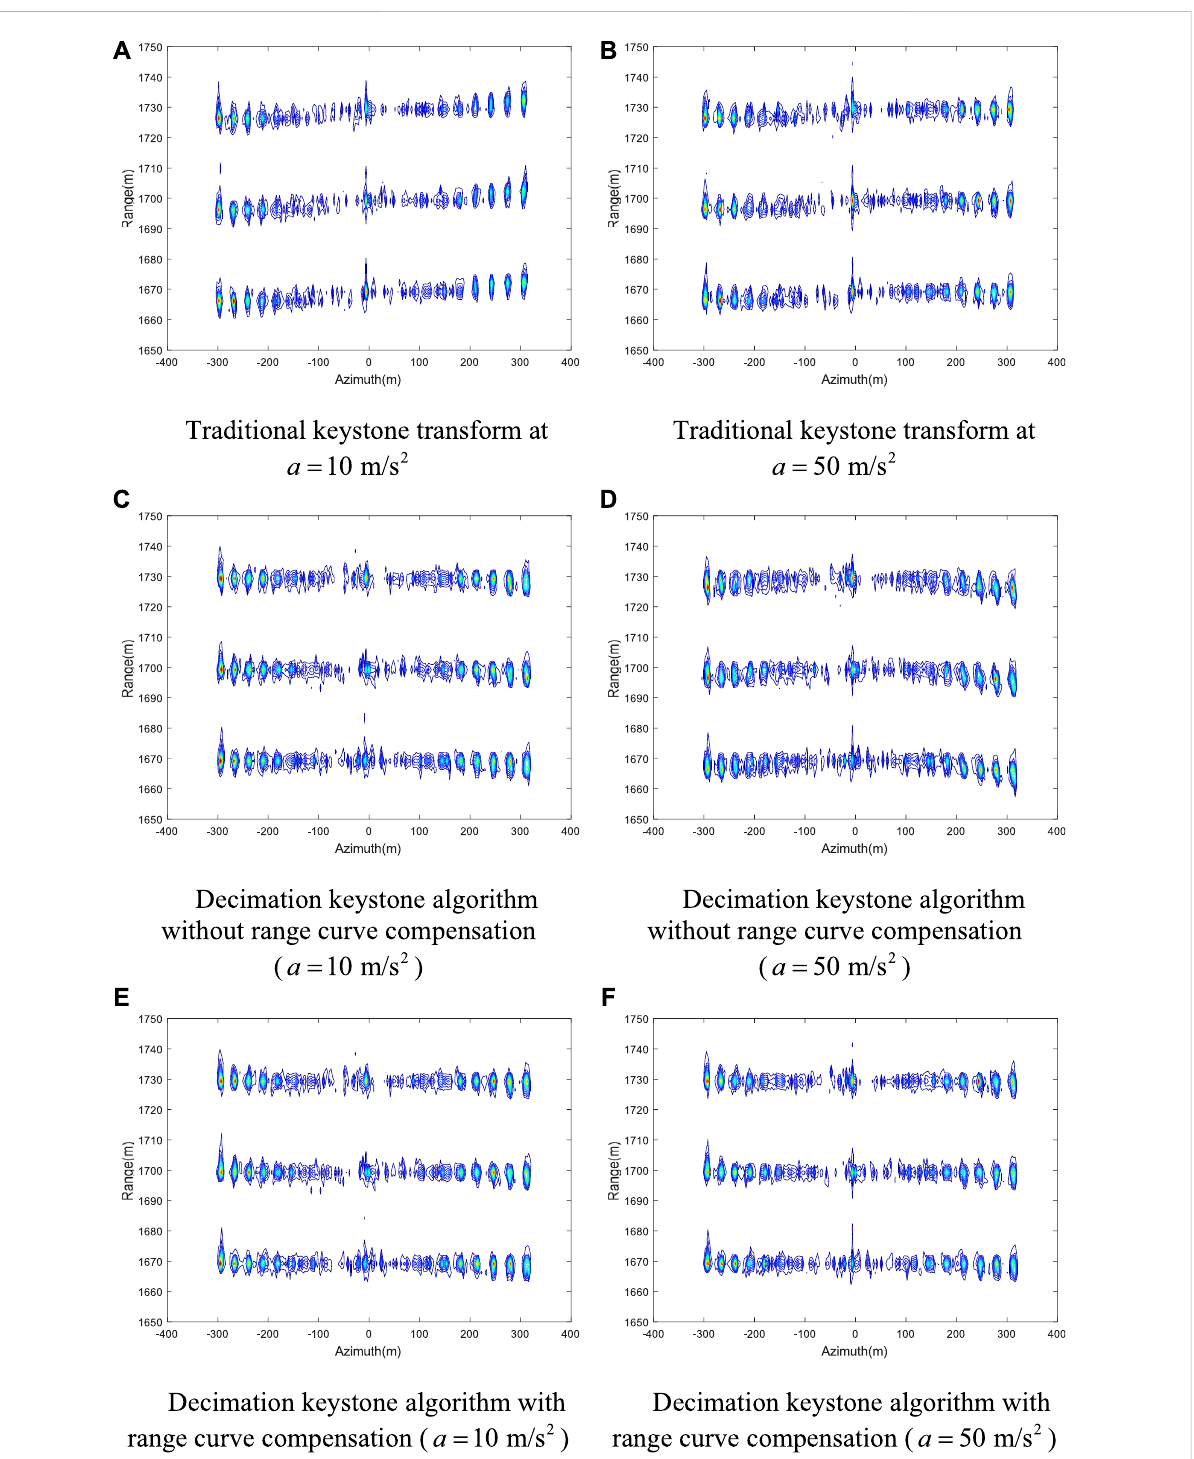
FIGURE 6 Comparison of image results of the uniform acceleration platform. (A) Traditional keystone transform at a (cid:2) 10 ( m / s ) 2 (B) Traditional keystone transform at a (cid:2) 50 ( m / s ) 2 . (C) Decimation keystone algorithm without range curve compensation ( a (cid:2) 10 ( m / s ) 2 ). (D) Decimation keystone algorithm without range curve compensation ( a (cid:2) 50 ( m / s ) 2 ). (E) Decimation keystone algorithm with range curve compensation ( a (cid:2) 10 ( m / s ) 2 ). (F) Decimation keystone algorithm with range curve compensation ( a (cid:2) 50 ( m / s ) 2